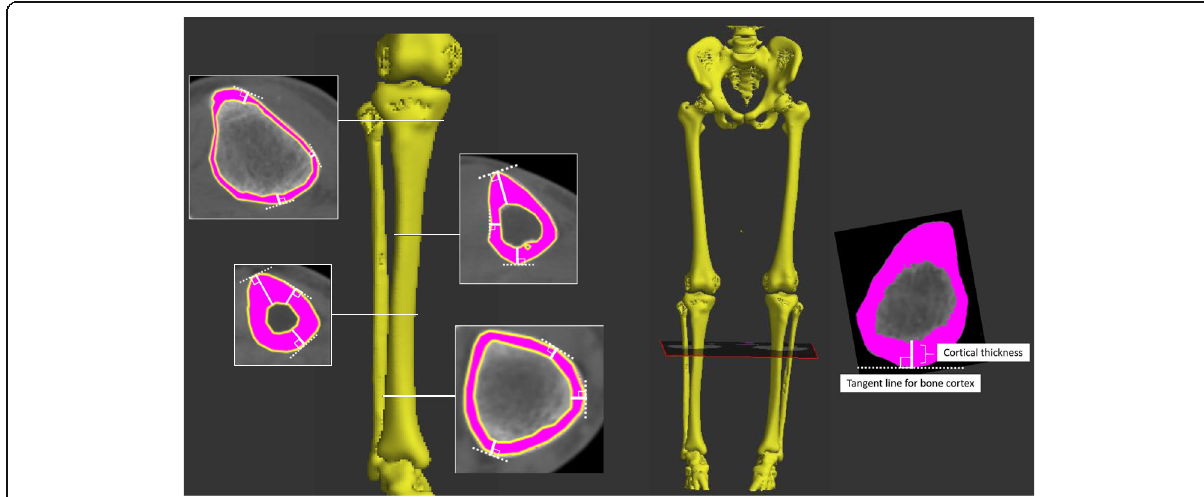
Fig. 2 Schematic illustration of the three-dimensional bone models and tibial cortical thickness mapped back onto the surface as a color. Cortical thickness of the tibia can be mapped across the entire surface of the tibia using a cortical mapping technique